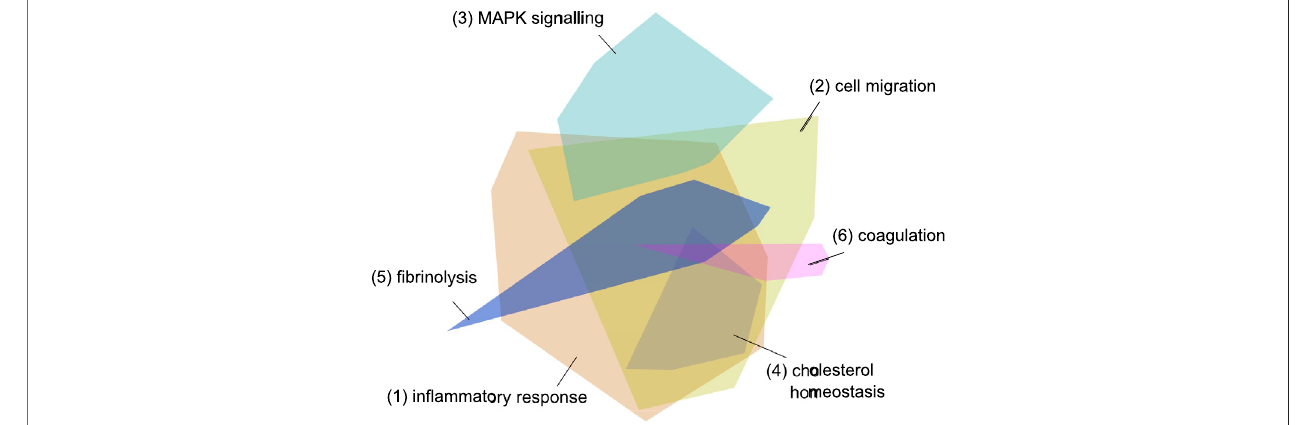
FIGURE 4 | Initial network - the 556 imported genes from the graph. The different colored modules re fl ect clusters of protein interactions which re fl ect speci fi c pathways and processes. The modules 1 and 2 re fl ect in fl ammatory processes, module 3 signaling pathways, module 4 cholesterol metabolism and modules 5 and 6 coagulation cascades. The three processes most strongly associated with each module are listed in Table 6 .